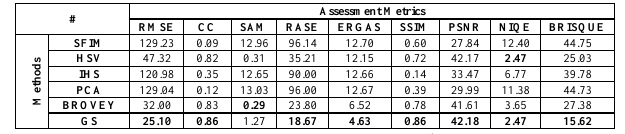
Table 2. Statistical results of Dataset 1. (+ Bold express the most successful